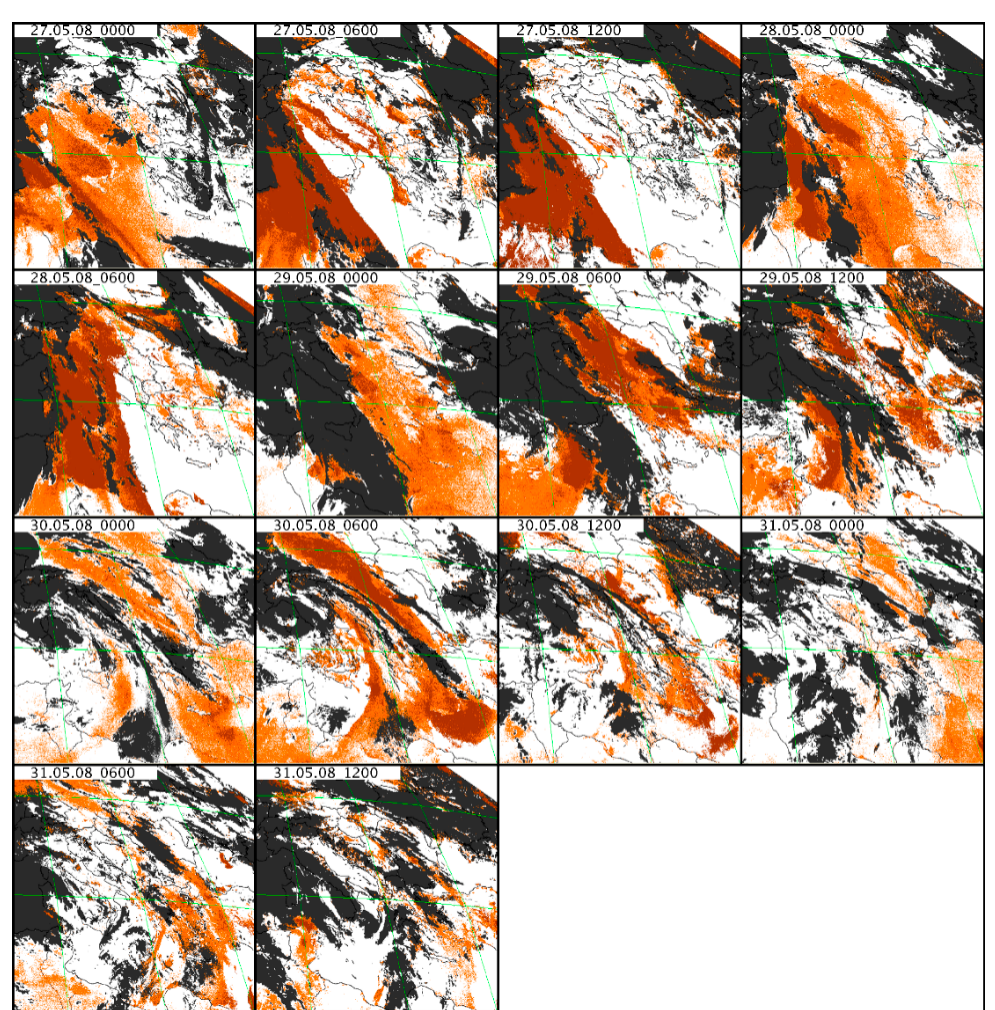
Figure 7. Time sequence, at a six hour interval, of e RST DUST maps generated between 27 May 2008 at 00:00 UTC and 31 May 2008 at 12:00 UTC, displaying regions characterized by a higher (brown pixels) and lower (orange pixels) probability of dust presence in the atmosphere. Note that the dust map of 28 May was not generated because of missing data.